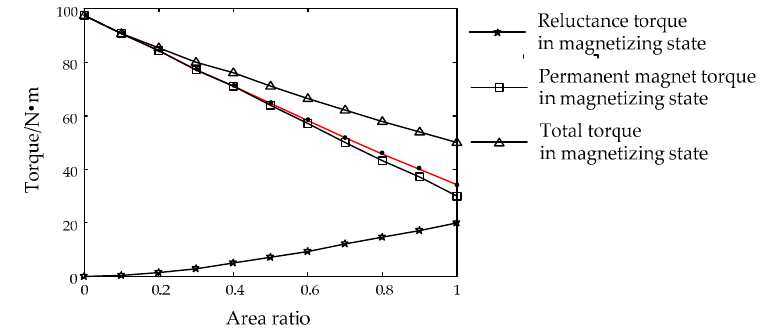
Figure 7. The curve of torque under rated-load conditions.